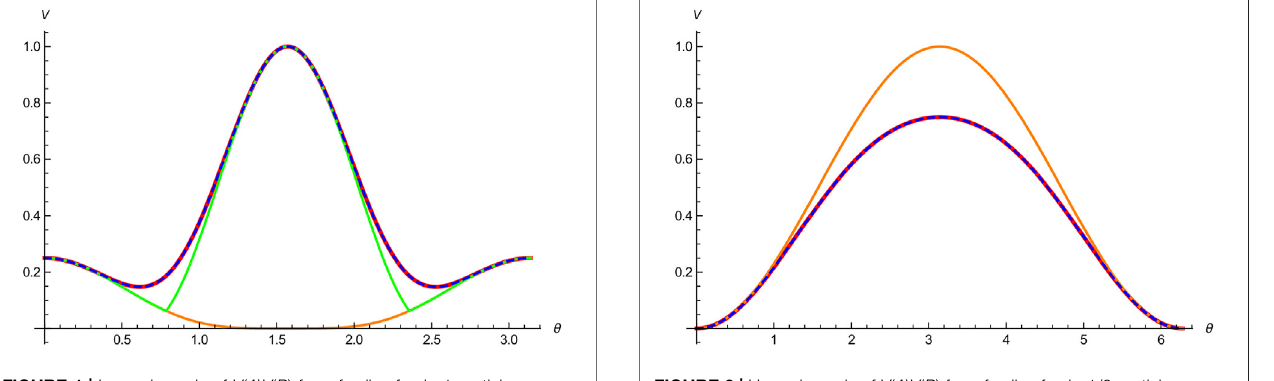
FIGURE 3 | Upper bounds of V ( A ) V ( B ) for a family of spin-1/2 particles ρ ( θ ): the product-form uncertainty relation V ( A ) V ( B ), our bound U and the bound of Ref. [34] are depicted in red, blue, and orange respectively.